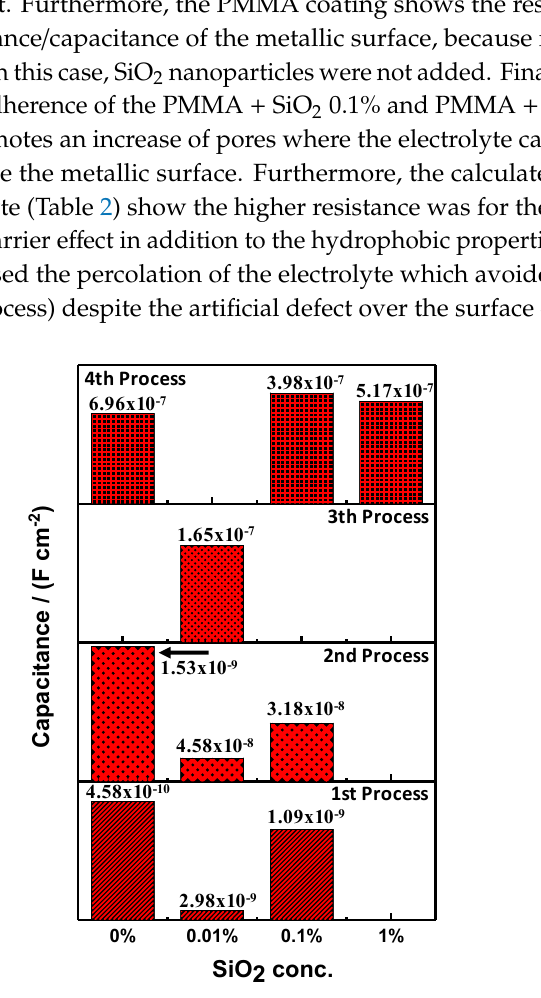
Figure 6. Capacitance values for the PMMA and PMMA with different concentrations of SiO 2 nanoparticles with an artificial defect on the surface.